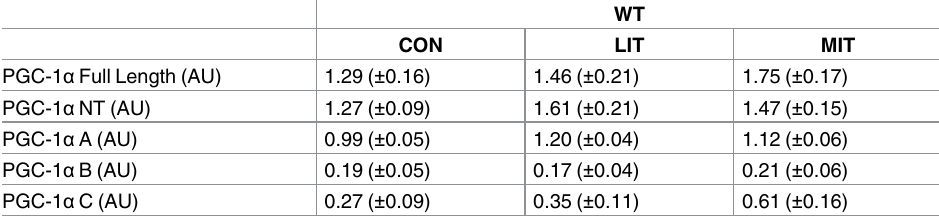
Table 3. Exercisetraining–PGC-1 α mRNA isoforms.